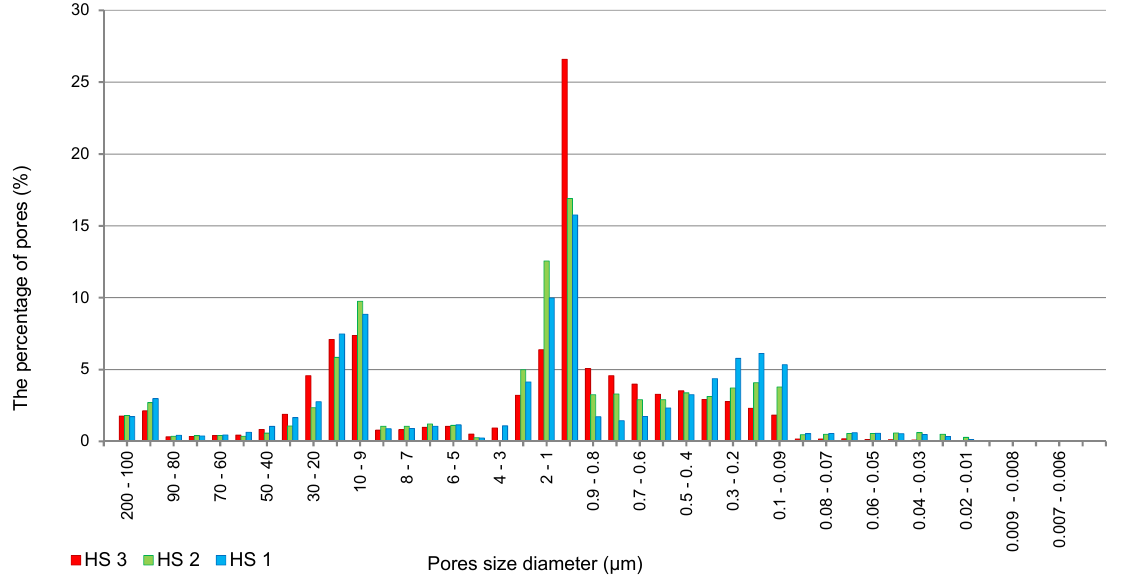
Figure 5. The percentage of the pores vs. pore size diameter ( μ m).